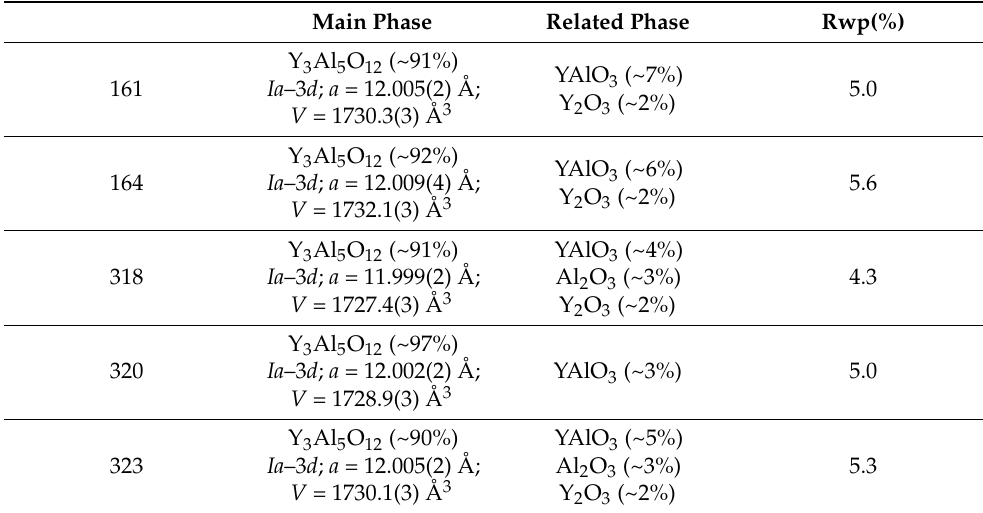
Table 1. Results of studying the phase composition of the samples.